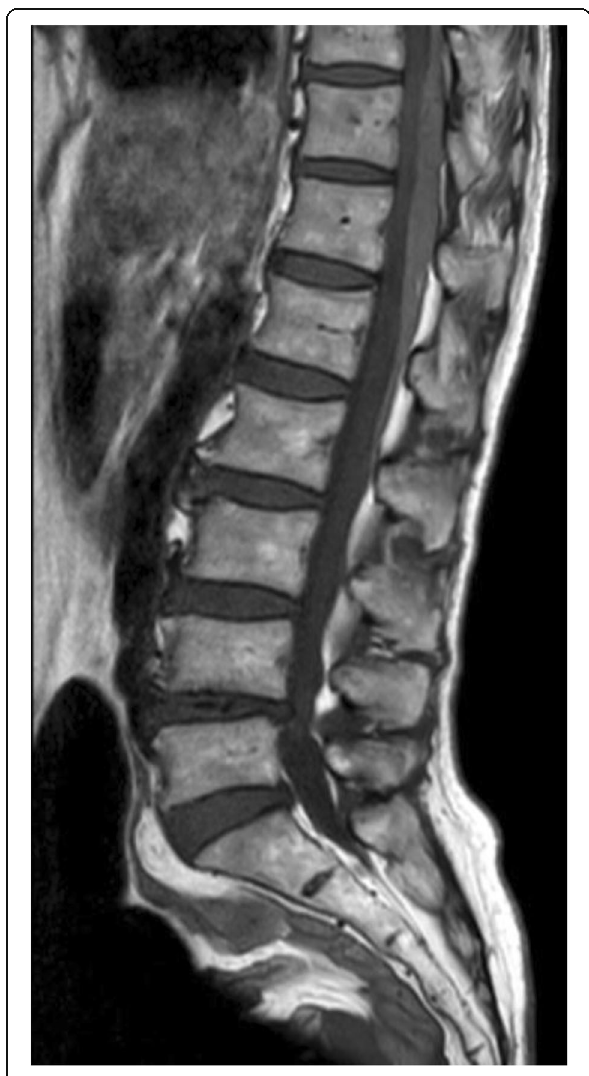
Fig. 1 T1-weighted image of the patient ’ s spine. T1-weighted magnetic resonance image showing compression of the posterior aspect of the spinal cord by a hematoma extending from T10 –